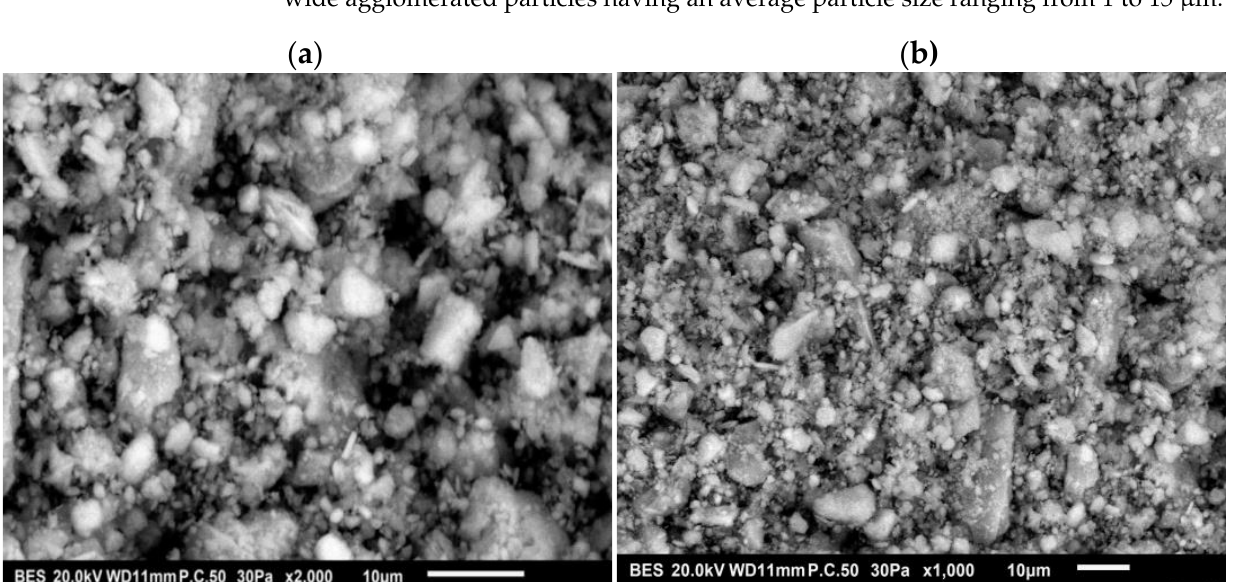
aggregates. Figure 6 depicts the plot of the particle fraction as a function of the particle size